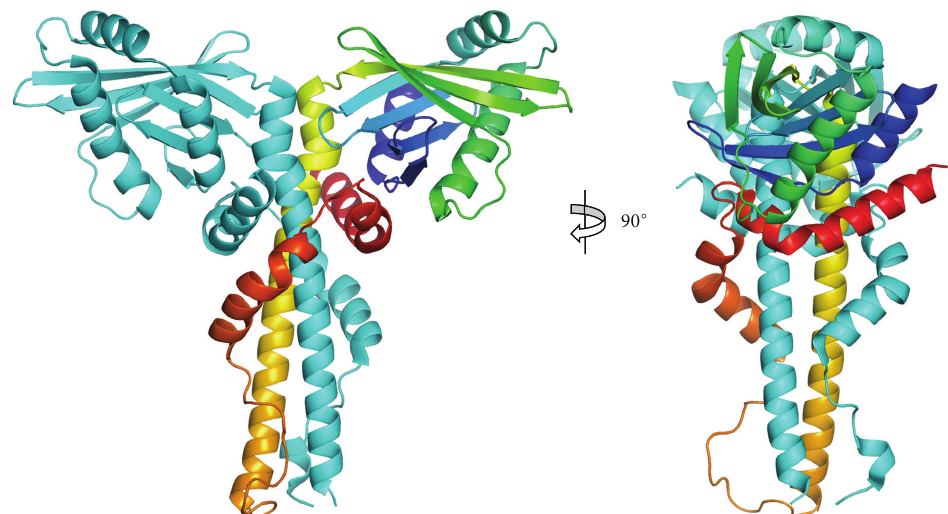
Figure 11: Crystal structure of XLF/Cernunnos. Ribbon diagram of the XLF/Cernunnos dimer. One protomer is rainbow colour going from N-terminus (blue) to C-terminus (red). Adapted from Li et al. [101].